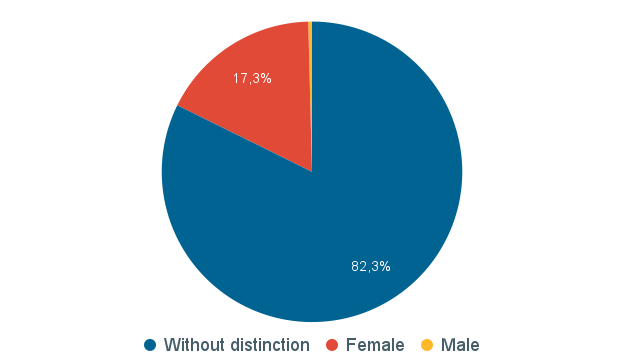
Figure 24. What did you think of the color palette? - Test